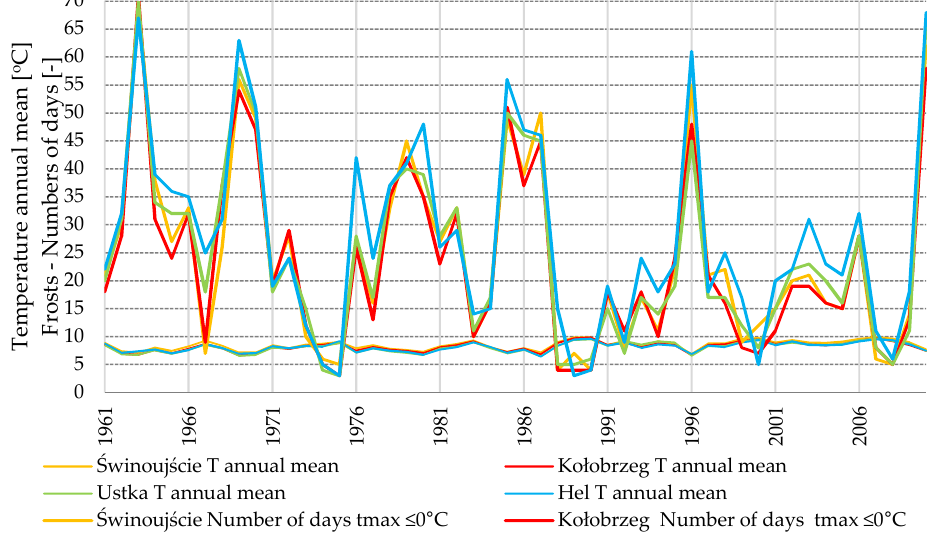
Figure 4. Annual dynamics of air temperature in the Polish Baltic coastal zone.